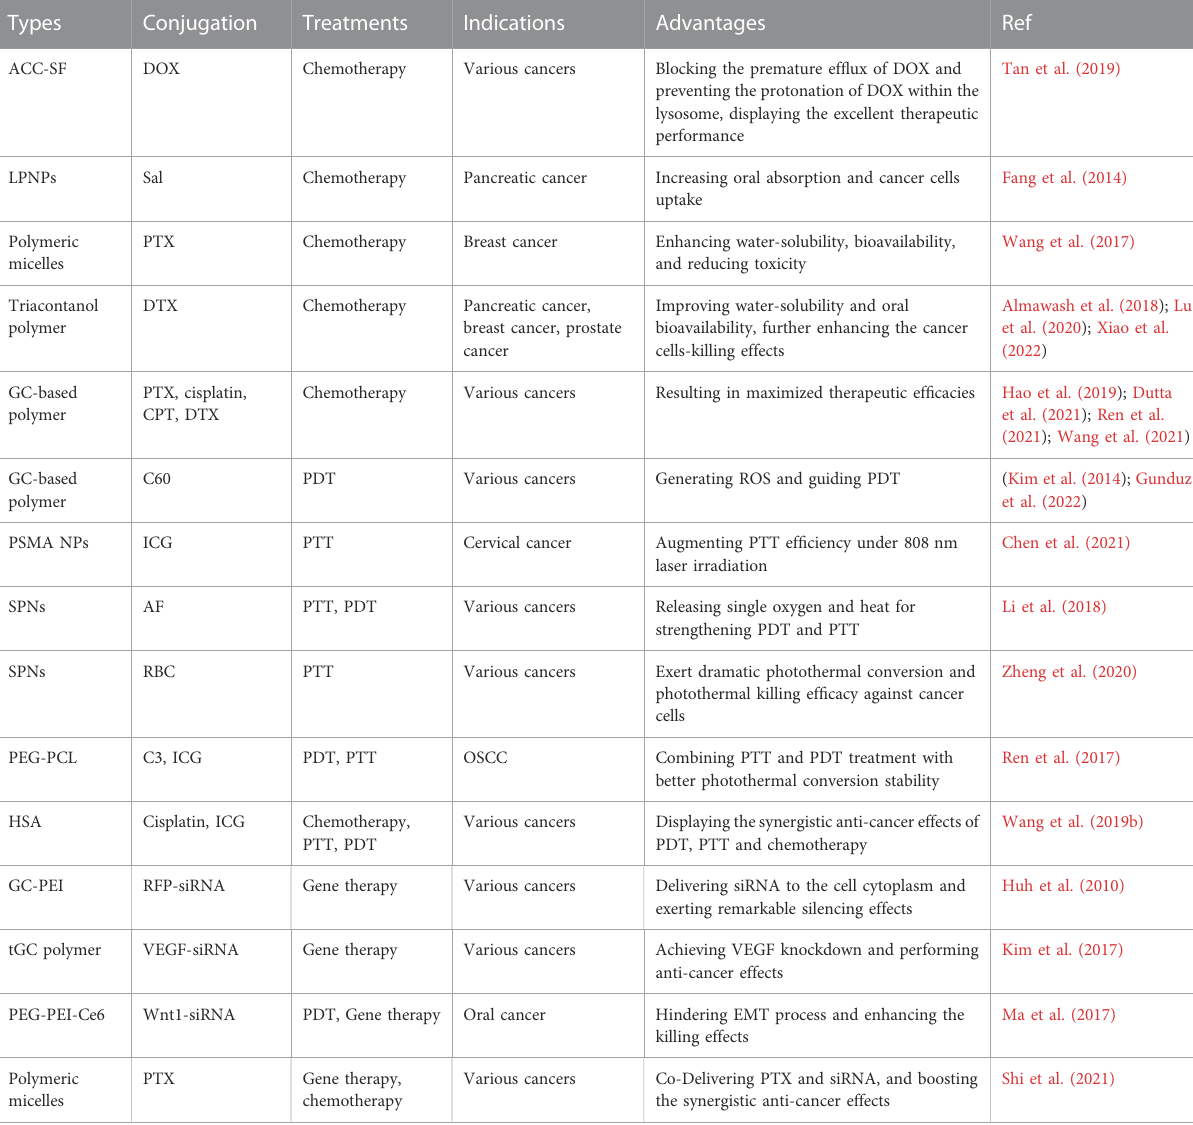
TABLE 2 The role of novel polymeric nanoagents in cancer